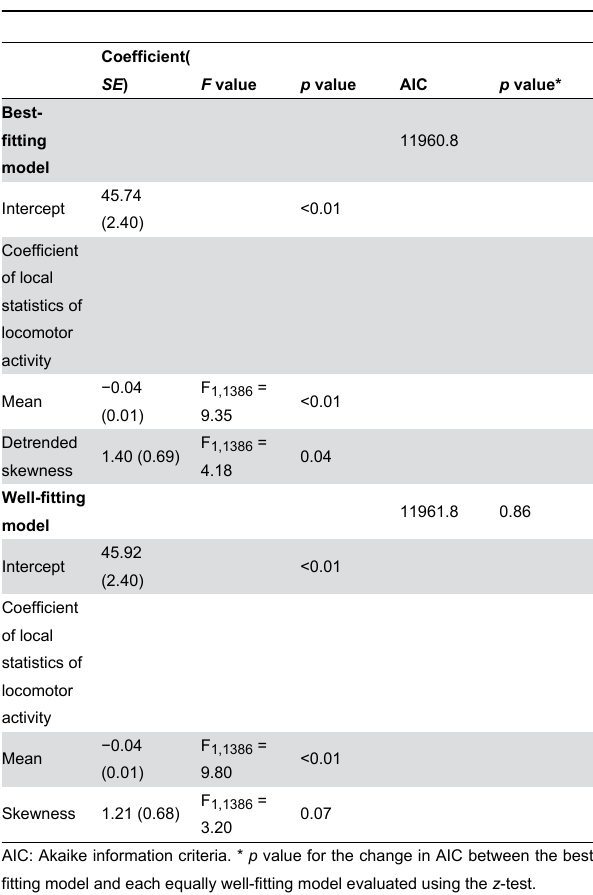
Table 4. Statistics of goodness-of-fit of best-fitting model and equally well-fitting